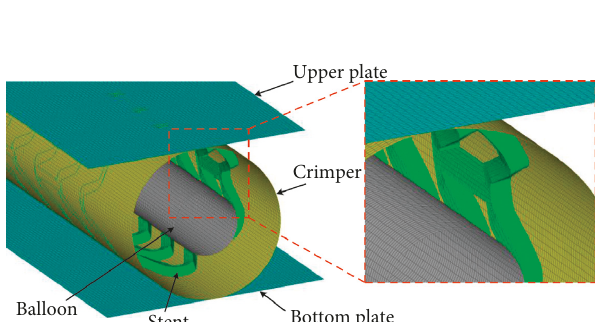
Figure 8: 3D finite element model of stent crimping, expansion, and planar compression processes.